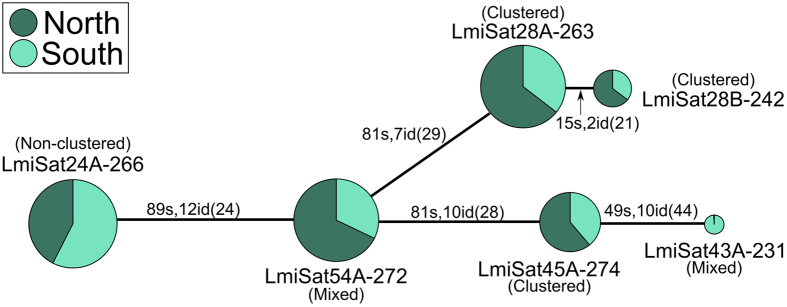
Minimum spanning tree for SF3 superfamily.The link size between haplotypes is proportional to the number of substitutions (s) and indels (id). In brackets, it is indicated the sum of nucleotides involved in the indels. SF3 was composed of six sequences corresponding to five different satDNAs, with lengths ranging between 231 and 274 bp. Note that they constitute a heterogeneous collection of satDNAs showing common descent and displaying all patterns of chromosome location and thus illustrating how long satDNAs may evolve by changing sequence and chromosome location patterns (see Table 1).